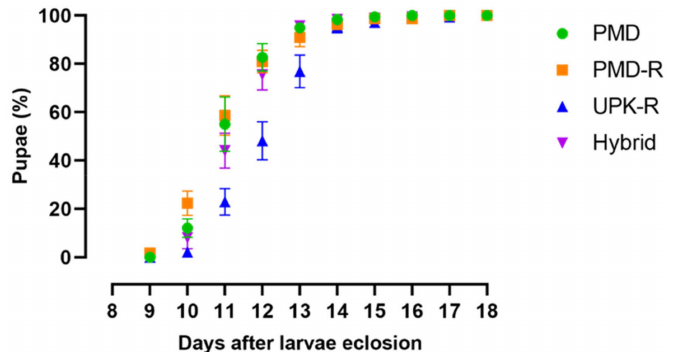
Figure 1. Development time of larvae to pupae of PMD, PMD-R, UPK-R strains, and F 1 (PMD-R × UPK-R) hybrid. The cumulative mean percentage of pupae formation and standard error are indicated.